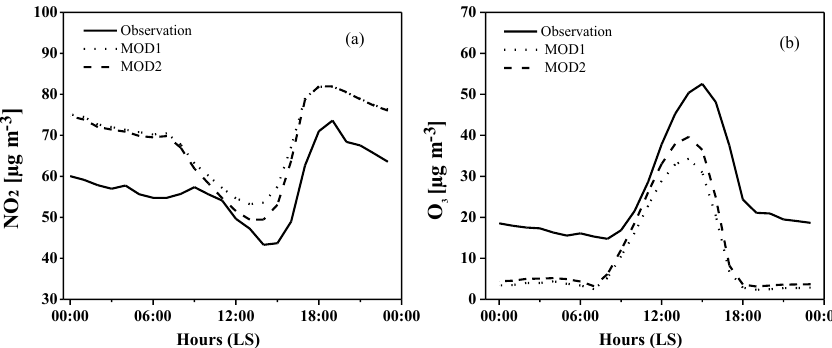
Figure 9. Diurnal variations in (a) NO 2 and (b) O 3 averaged over 13 cities in Jiangsu Province (Fig.